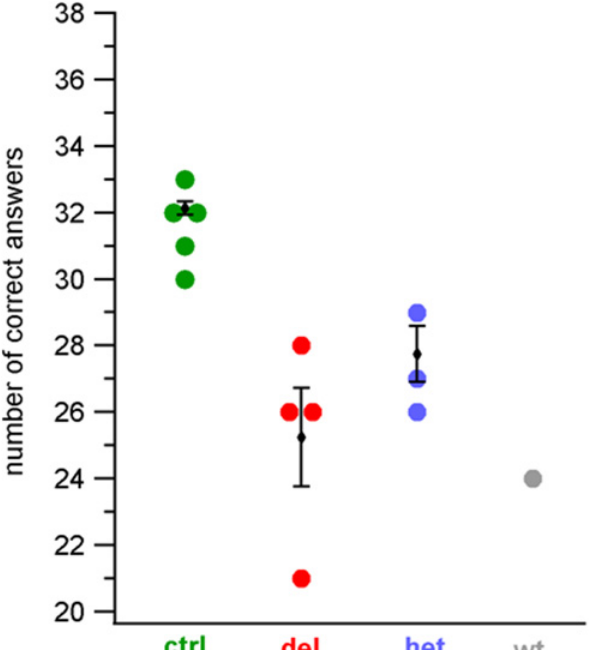
Figure 2. Assessment of the olfactory function with the adapted Italian UPSIT test. Number of correct answers to the 34 odorants selected for our adapted Italian UPSIT test for the subgroup of healthy subjects (indicated as control, “ ctrl ” , green, n = 5), or for members of the family homozygous for the 253 kb deletion in chromosome 12 (indicated as “ del ” , red, n = 4), heterozygous for the 253 kb deletion (indicated as “ het ” , blue, n = 3), wild type (indicated as “ wt ” , grey, n = 1).